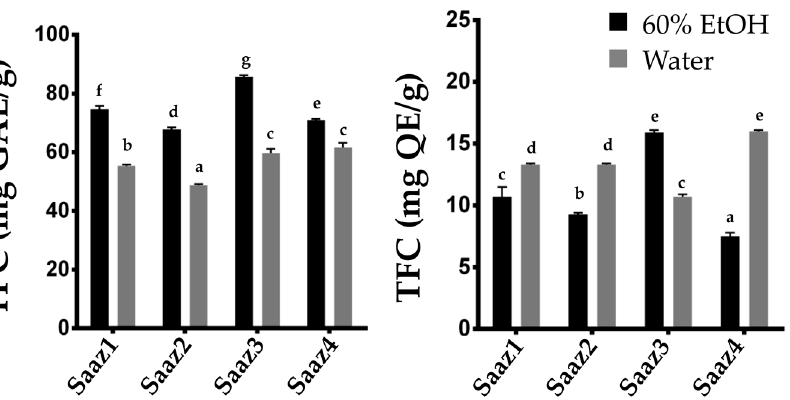
Figure 2. Comparison of TPC and TFC contents of Saaz cultivar from different cultivated regions. Total Phenolic content (left), Total flavonoid content (right). The letters above each point indicate a significant difference at the 5% level (Tukey HSD tests, n = 3).